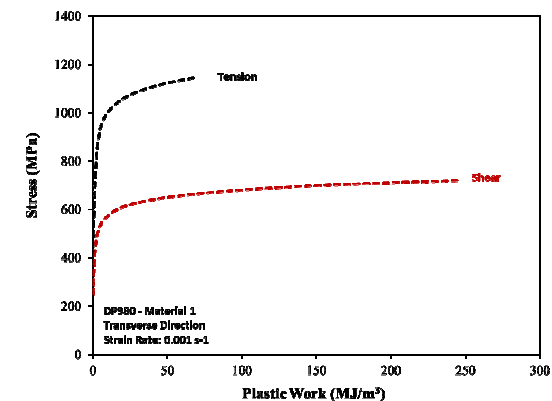
Fig. 11. Comparison of true tensile and shear stress versus plastic work for Material 1.